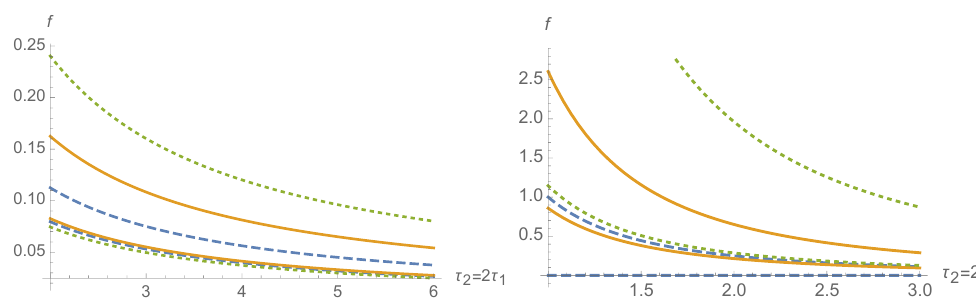
Figure 2 . The “decay constants”, defined as the square-roots of the eigenvalues of the Kähler √ metric divided by 2 2 π, for two light axions, assuming a volume of the form (3.27). Left: two- axion scenario, cases β = 0 (solid) , − 2 / 3 (dashed) , − 1 (dotted), with ( p 1 , p 2 , p 3 ) = (1 / 2 , 1 , 0) and ( q 1 , q 2 , q 3 ) = (3 / 2 , 0 , 0) . We fixed the Kähler moduli to satisfy the relation τ 2 = 2 τ 1 ; general behav- iors are similar for other relations. Right: three-axion scenario, cases for ( p 1 , p 2 , p 3 ) = (1 / 2 , 1 , 0) and ( q 1 , q 2 , q 3 ) = (0 , 0 , 3 / 2) . Solid, dashed and dotted curves correspond to ( β, τ 1 /τ 2 , τ 1 /τ 3 ) = (0 , 1 / 2 , 2) , ( − 1 , 1 / 2 , 2) , ( − 1 , 1 / 2 , 1) , respectively. In this case τ 3 may be interpreted as a small